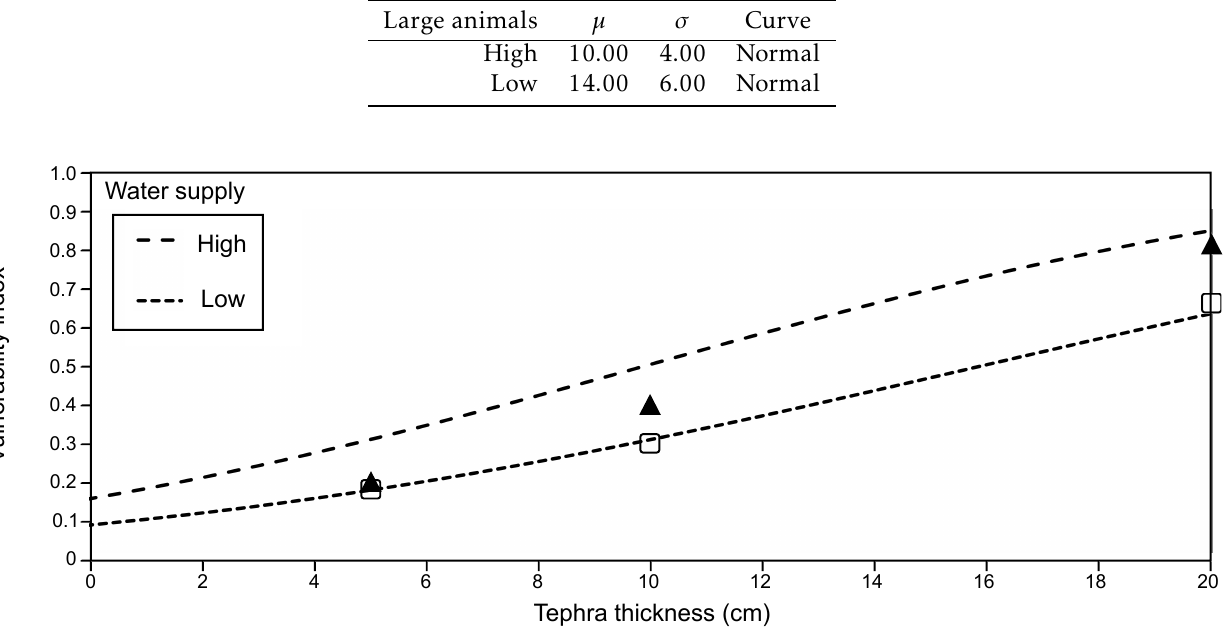
Figure A5: Estimated high and low vulnerability indices large animals exposed to 0—20 cm of tephra fall from the Laacher See eruption. Table A5 – Fitting parameters for vulnerability curves based on food supply (large animals) in Figure A5.